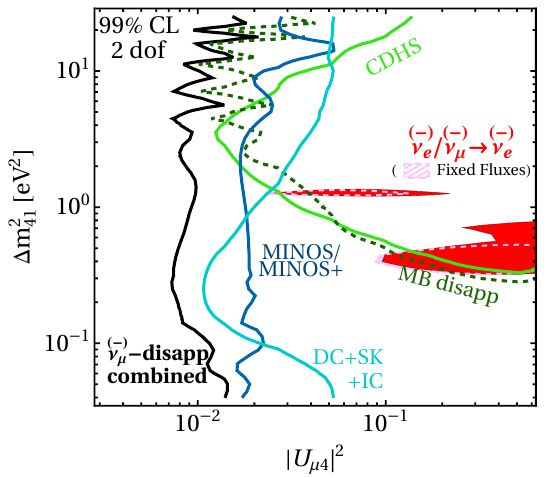
– ) ν µ disappearance driven by a – ) ν → ( – ) ν µ e